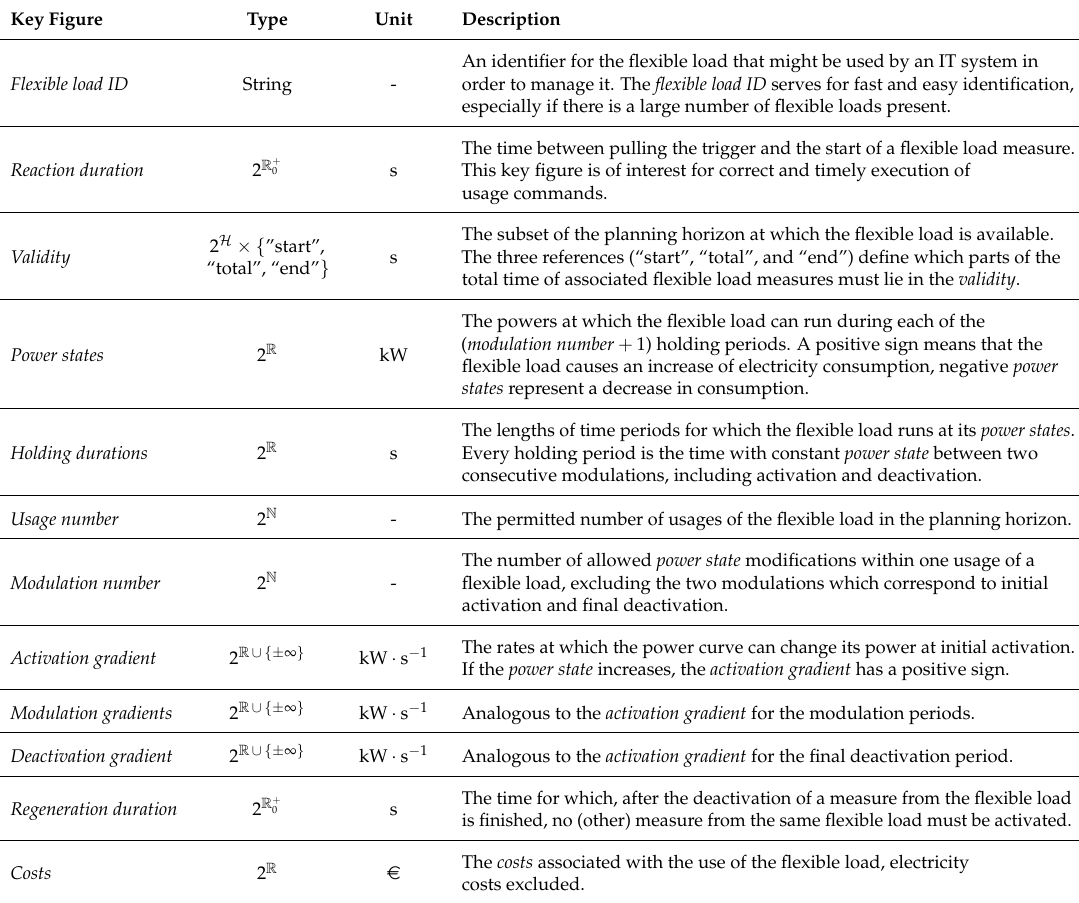
Table 1. Key figures for flexible